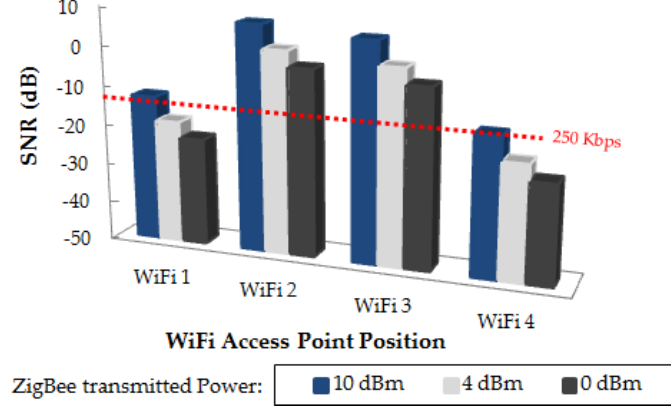
Figure 15. Estimated SNR values at receiver position for different WiFi access point positions, for different ZigBee transmitted power levels.